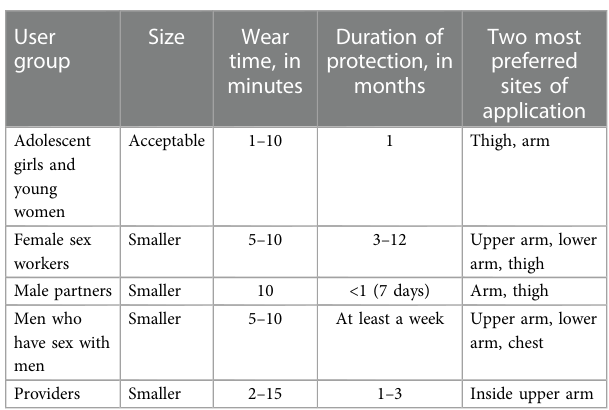
TABLE 5 Summary of MAP feature preferences, by user